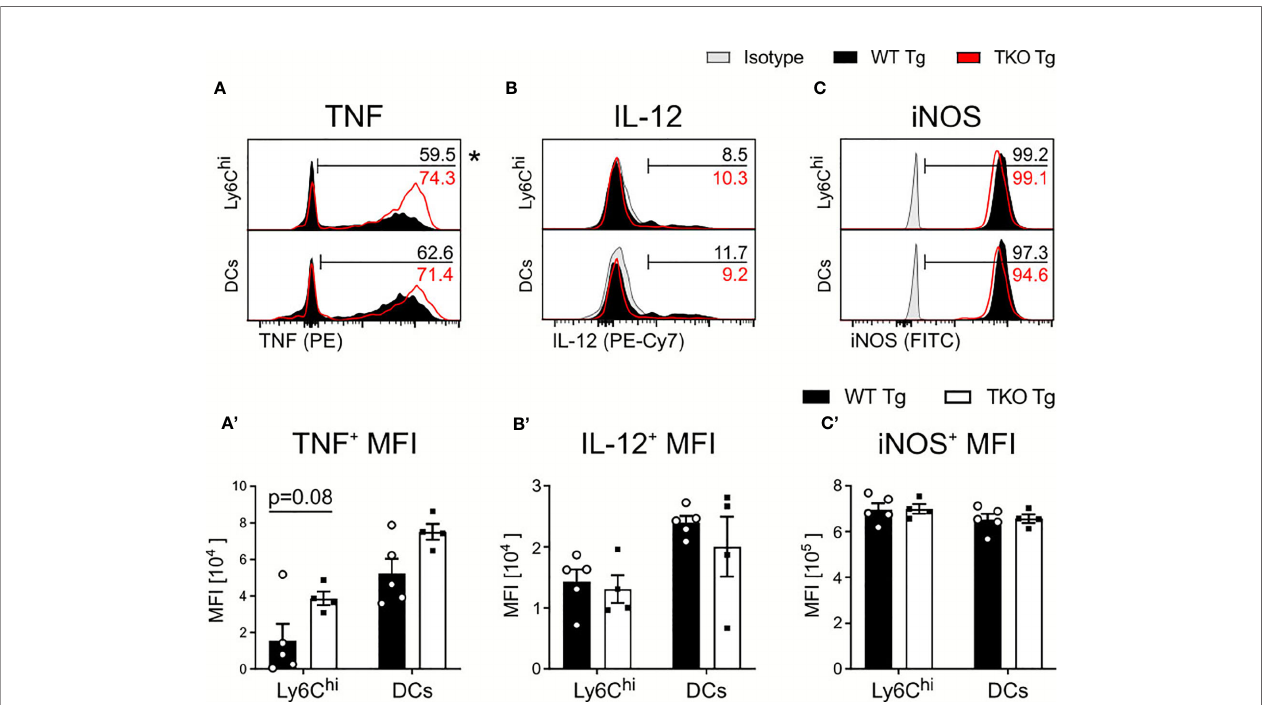
FIGURE 3 | Cytokine production by APCs in spleens of T. gondii infected mice. Immune cells were isolated from the spleens of T. gondii infected WT (WT Tg, n=5) and TKO (TKO Tg, n=4) mice on day 10 p.i. Isolated cells were then restimulated with T. gondii -lysate antigen (TLA) for 6 hours, stained and analyzed by fl ow cytometry. (A – C) Histograms of Ly6C hi monocytes and DCs intracellular production of (A) TNF (B) IL-12 and (C) iNOS and their resulting MFI expression (A ’– C ’ ) . The histogram values (right side) represent the average percentage of positively expressing cells (determined by isotype control; in gray) for each respective immune marker and group (WT in black; TKO in red outline). The bar (A – C) outlines where positive expression begins for each respective cell and marker. Data shown in (A – C) are representatives of three individual experiments. Data shown in (A ’– C ’ ) represent three independent experiments; symbols represent individual animals, columns represent mean values and error bars represent ± SEM. 2way ANOVA following Fisher ’ s LSD test was used for statistical analysis. *P <